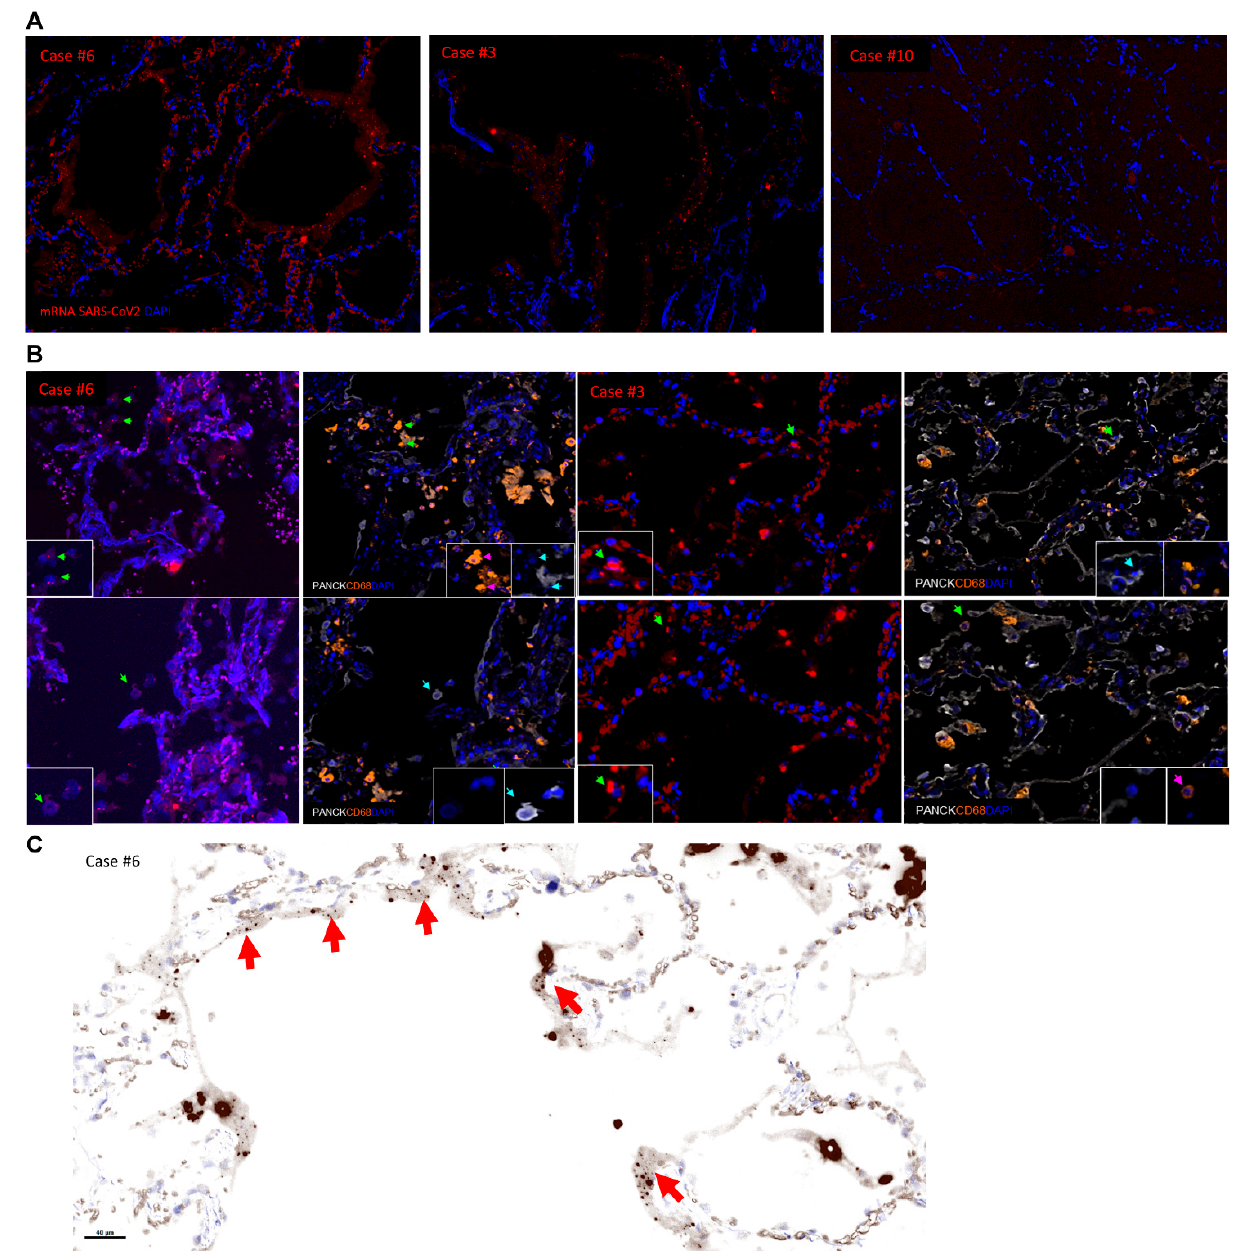
Figure 3. Detection of actively transcribed SARS-CoV-2 in different cellular compartments of lung tissue. ( A ) In situ expression of SARS-CoV-2 mRNA (red), detected by RNAscope, in lung tissues from three infected patients with different levels of SARS-CoV-2 viral loads as detected by RT-qPCR in FFPE lung tissue. Granular positivity highlights hyaline membranes in RT-qPCR highly positive cases #3 and #6. Lack of in situ expression of SARS-CoV-2 mRNA in case #10, which showed also very low SARS-CoV-2 copy numbers in the RT-qPCR assay. ( B ) SARS-CoV-2 mRNA expression in pneumocytes and macrophages in two representative patients (cases #3 and #6), as detected by RNAscope and multiplex imaging on sequential lung tissue sections (magnifications as insets). Green arrows point to cells positive for viral mRNA. Cyan arrows highlight SARS-CoV-2 mRNA positive pneumocytes, defined by PANCK-expression. Magenta arrows depict SARS-CoV-2 mRNA positive macrophages, defined by CD68-positivity. ( C ) Lung tissue (case #6) stained for SARS-CoV2 mRNA expression (RNAscope). A simulated H&E image (generated from a fluorescent image processed using the inForm software) shows tissue areas positive for SARS-CoV-2 mRNA signal (red arrows) mainly associated with hyaline membranes. All images were acquired on the Vectra Polaris microscope using a 20× objective magnification.